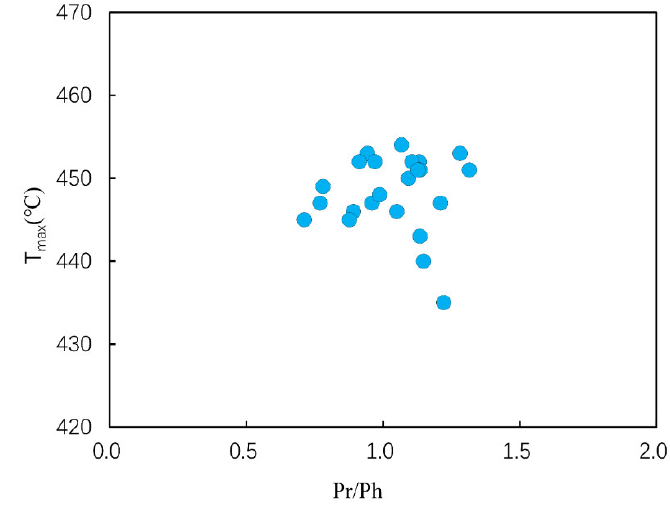
Figure 11. Diagram of Pr/Ph and T max. Figure 10. Diagram of Pr/Ph and T max .